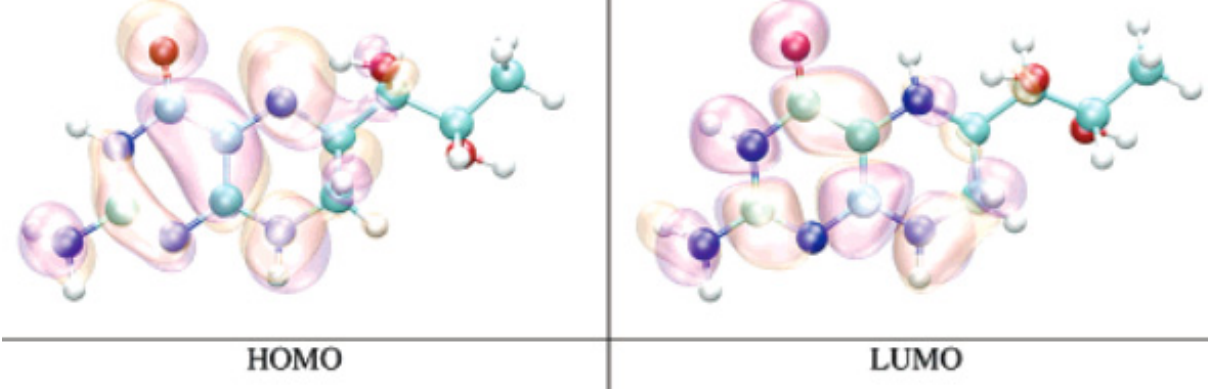
Figure 7. Frontier molecular orbitals of H4Bip [126]. ©2006 American Chemical Society.